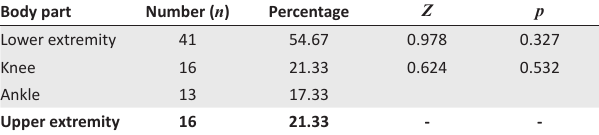
Table 2. The difference between the frequency of knee and ankle injuries was not significant ( p = 0.532). TABLE 2: Comparison of upper and lower extremities injury. Body part